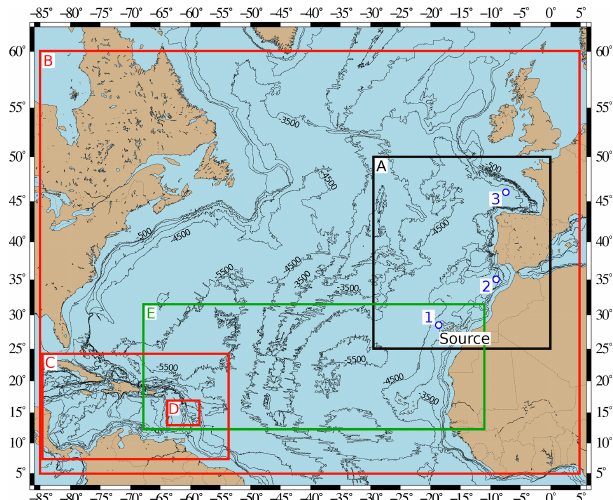
Figure 4. Computational domains for Calypso at 2km (A) resolu- tion in black, FUNWAVE-TVD at 2.7km (B), 930m (C) and 310m (D) resolutions in red, and SCHISM at variable resolution (E) in green. Bathymetric contours range from − 500 to − 7500m every 1000m. Gauges 1, 2 and 3 are marked by white and blue points.